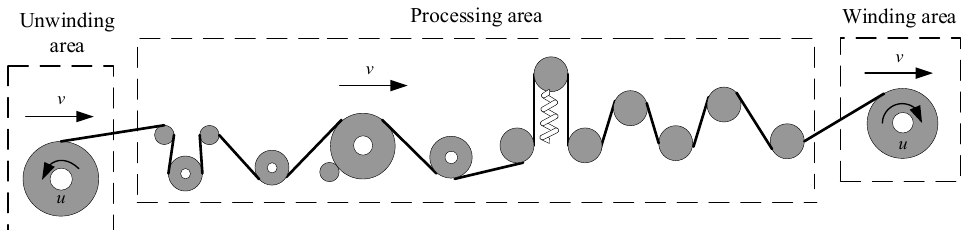
Figure 1. Mechanical structure of insulating tape system.